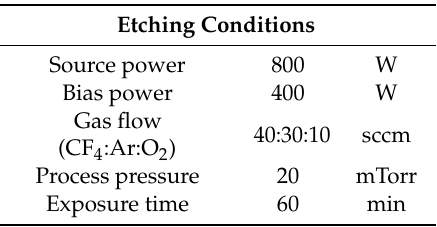
Figure 1. Schematic diagram of equipment: ( a ) ICP-RIE etching system, ( b ) CCP particle evaluation system. Table 2. Plasma-etching